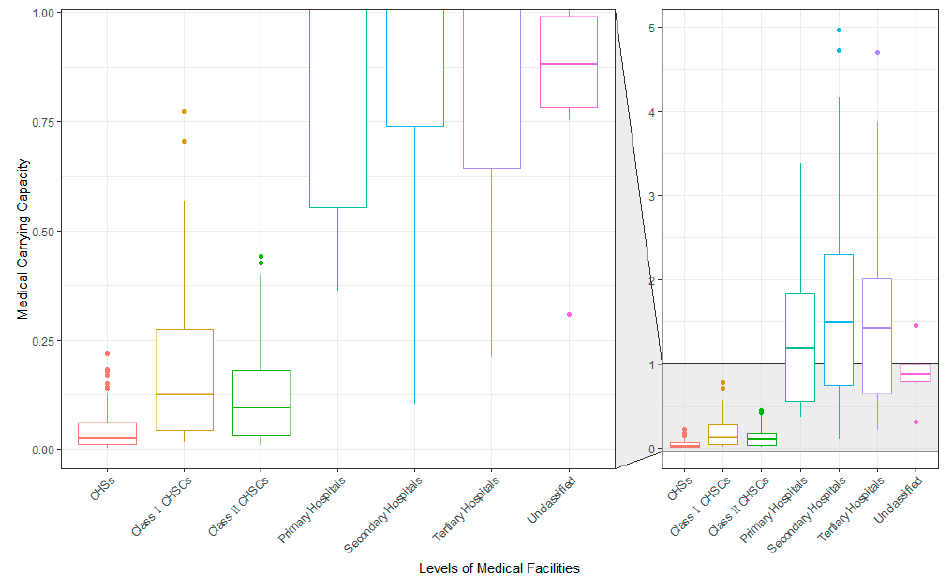
Figure 8. Boxplot of the carrying capacity of public medical resources at different levels in Shenzhen. Overall, medical overloading occurs in multiple districts. The overall medical config- uration is relatively uneven, with some areas unable to meet the needs of residents. Except for the CHSCs, the carrying capacity of medical resources in Shenzhen is centered in the central and western parts of the city and gradually decreases to the east and west, thus gradually reducing the efficiency of medical resource utilization. The carrying-capacity index of Shenzhen’s CHSCs is low, the utilization rate is low, and resources need to be optimized and integrated. 4. Discussion 4.1. Characteristics of Healthcare Resources Carrying in Shenzhen The overall public medical service in Shenzhen shows a polycentric development pattern, with the density of medical facilities being higher in the west and lower in the east. The service potential agglomeration centers of medical facilities in Shenzhen are scat- tered in various districts and vary in size. The gravitational value connection line between each medical point and the TAZ is radially gathered in medical facilities with a high-grade scale, which is related to the superior service quality of the high-grade hospitals them- selves and a larger radiating population. Multiple medical facilities are overloaded, and firstly, the reasons for this are analyzed in conjunction with the population size distribu- tion map of the district (Figure 2), mainly for the following two reasons. First, the supply of medical resources is insufficient, and the population density near medical facilities is too high, so the limited medical resources cannot meet the needs of residents, which